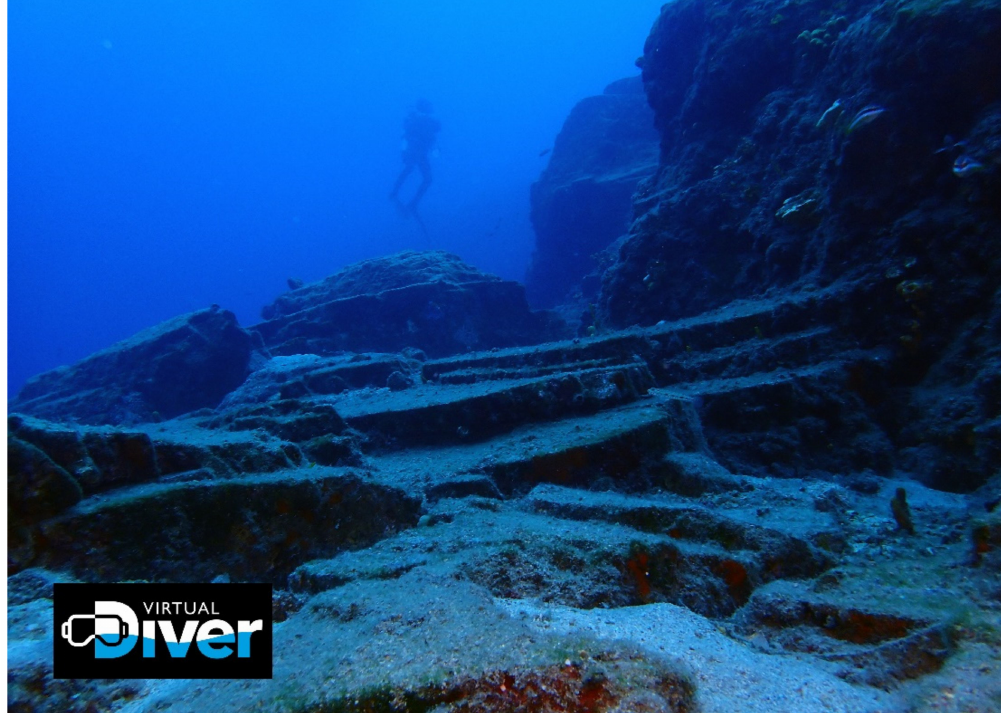
Figure 11. Underwater photo, case in point of the marvelous underwater volcanic character of Santorini region, showing the “Atlantis steps” at the submarine area near Thirasia island (credits to Othonas